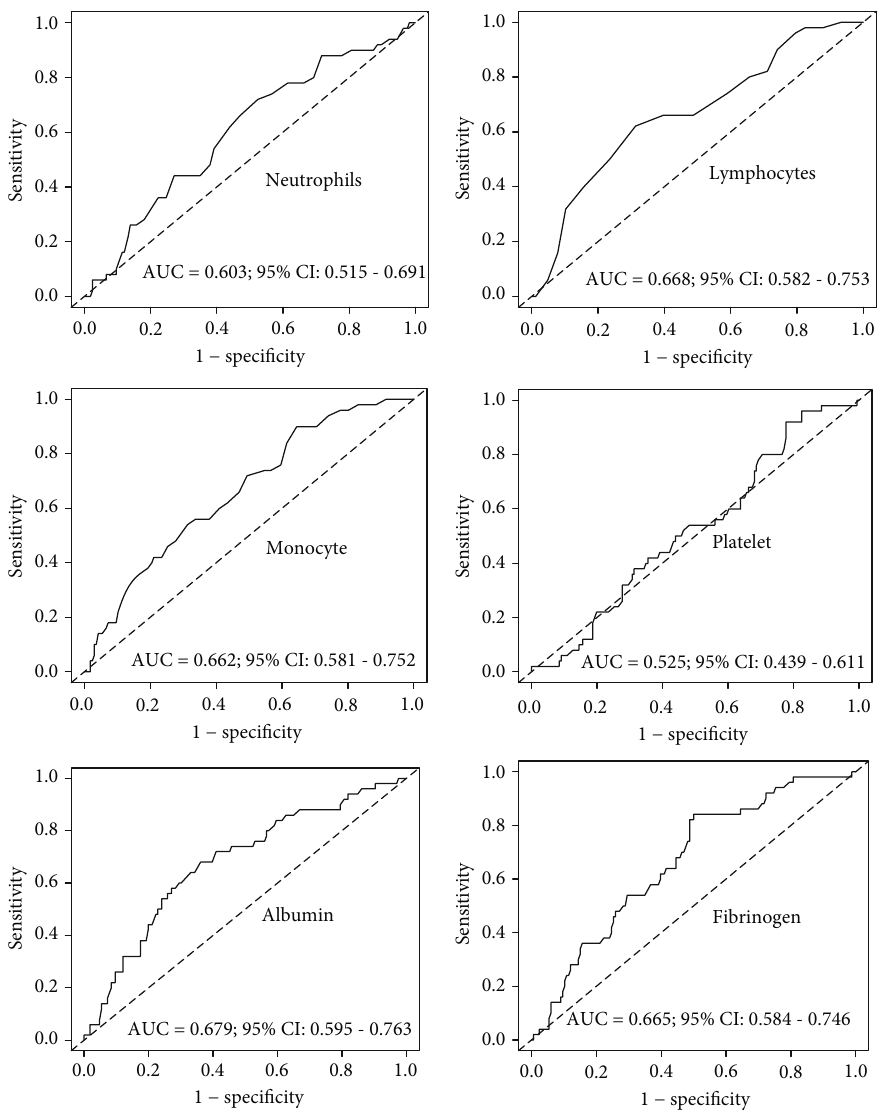
Figure 1: The predictive ability of the neutrophil, lymphocyte, monocyte, platelet, albumin, and fi brinogen levels was calculated by ROC curves. AUC: area under the curve; CI: con fi dence